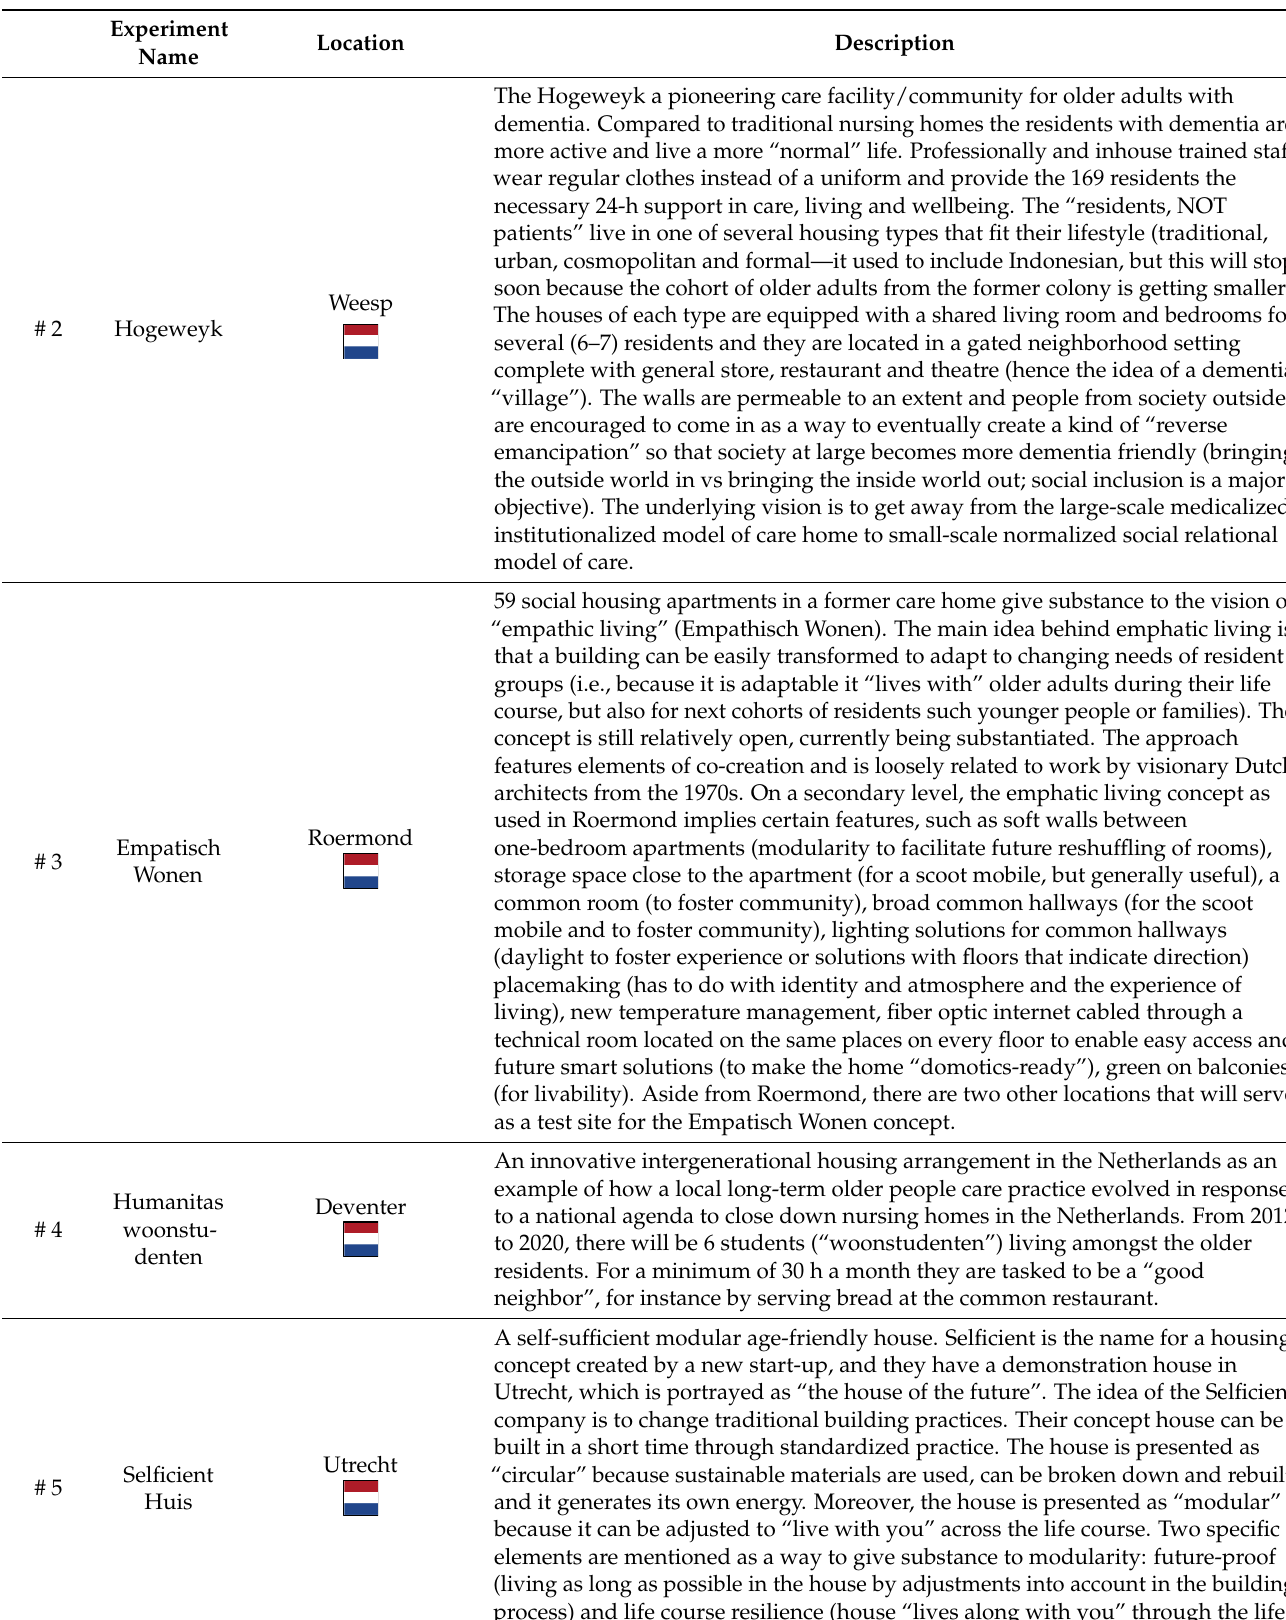
Table 2. Overview of 8 key age-friendly home experiments in the Netherlands, France, Ireland and Poland (see Table A1 in Appendix A for the complete overview of 53 experiments).